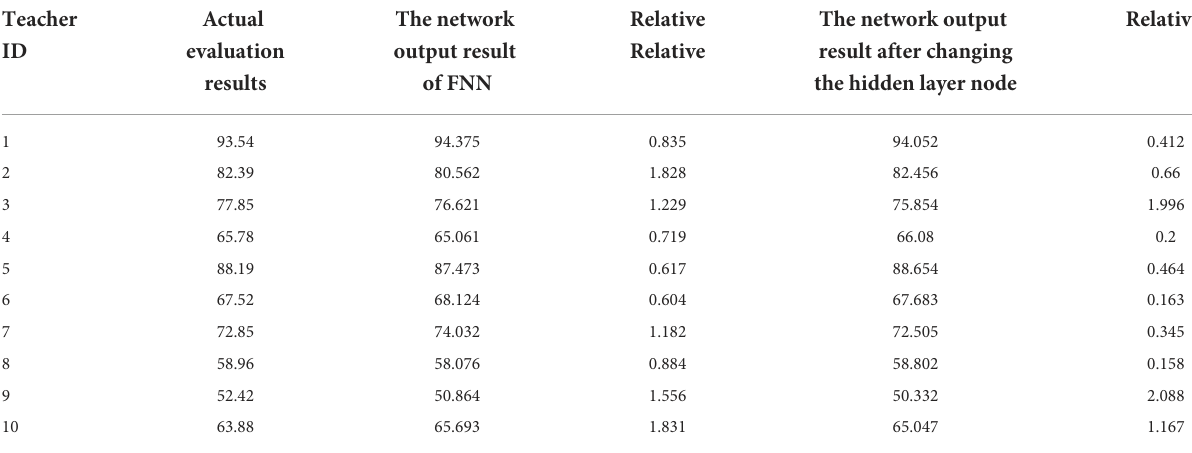
TABLE 4 The result of the experiment